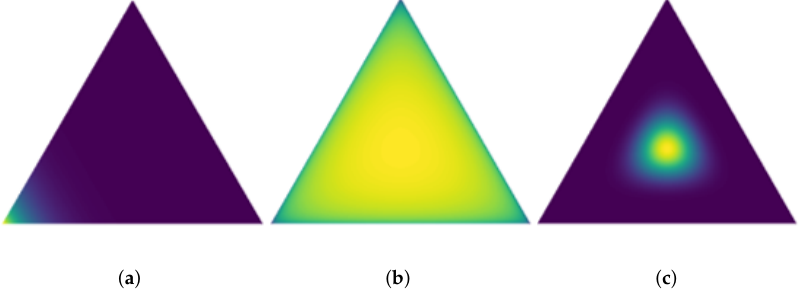
Figure 1. Visualization of Dirichlet distribution, where θ = { θ 1 , θ 2 , θ 3 } and θ 1 , θ 2 , θ 3 ≥ 0, θ 1 + θ 2 + θ 3 = 1. ( a ) α = ( 10,1,1 ) ; ( b ) α = ( 1.001,1.001,1.001 ) ; ( c ) α = ( 10,10,10 ) . Bright yellow represents high probability, and dark blue represents low probability. In the multi-classification problem, each vertex is regarded as a